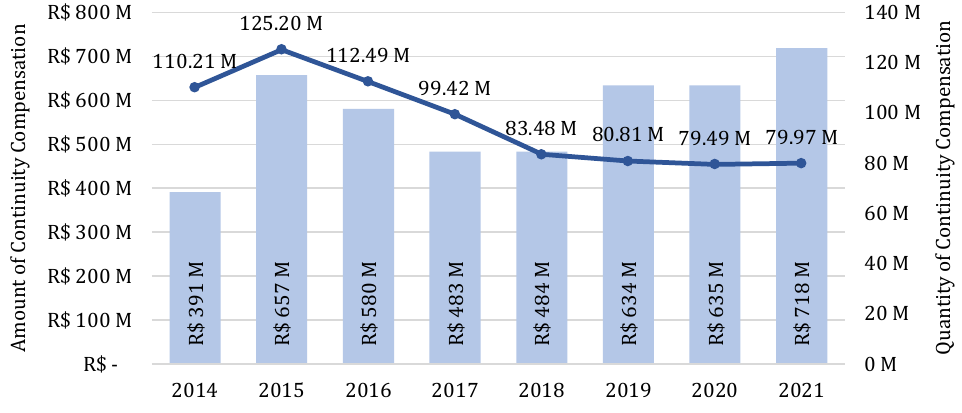
Figure 1. Compensation in Brazil paid directly to consumers.